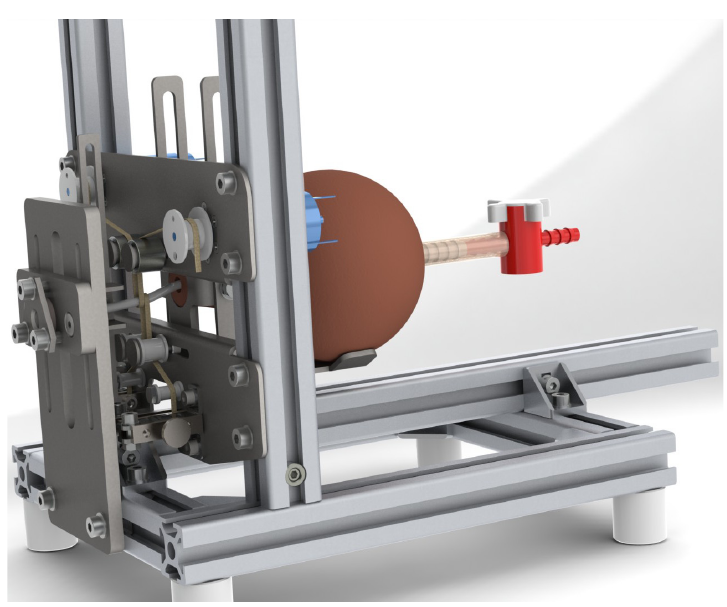
Figure 2. CAD-Rendering of the test stand.